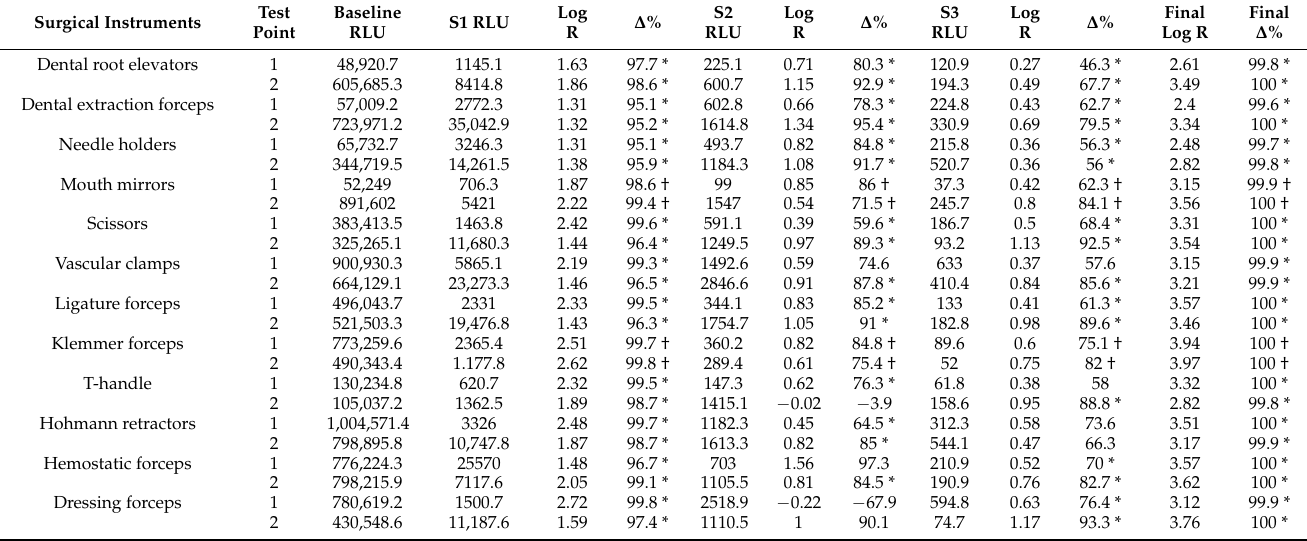
Table 2. Results of determination of adenosine triphosphate (ATP) bioluminescence in surgical instruments before cleaning and after each step: average relative light units (RLUs) values; logarithmic reduction (Log R); percentage of reduction ( ∆ %). Surgical Instruments